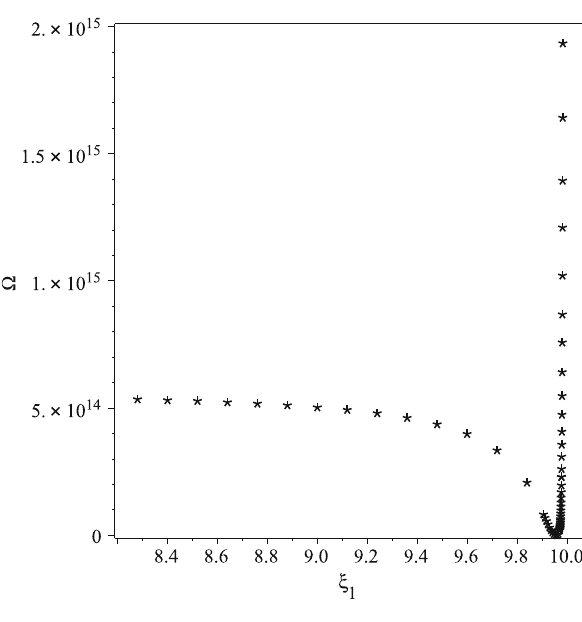
= 9 . 96. (cid:5)(ξ ∗ = 1 1